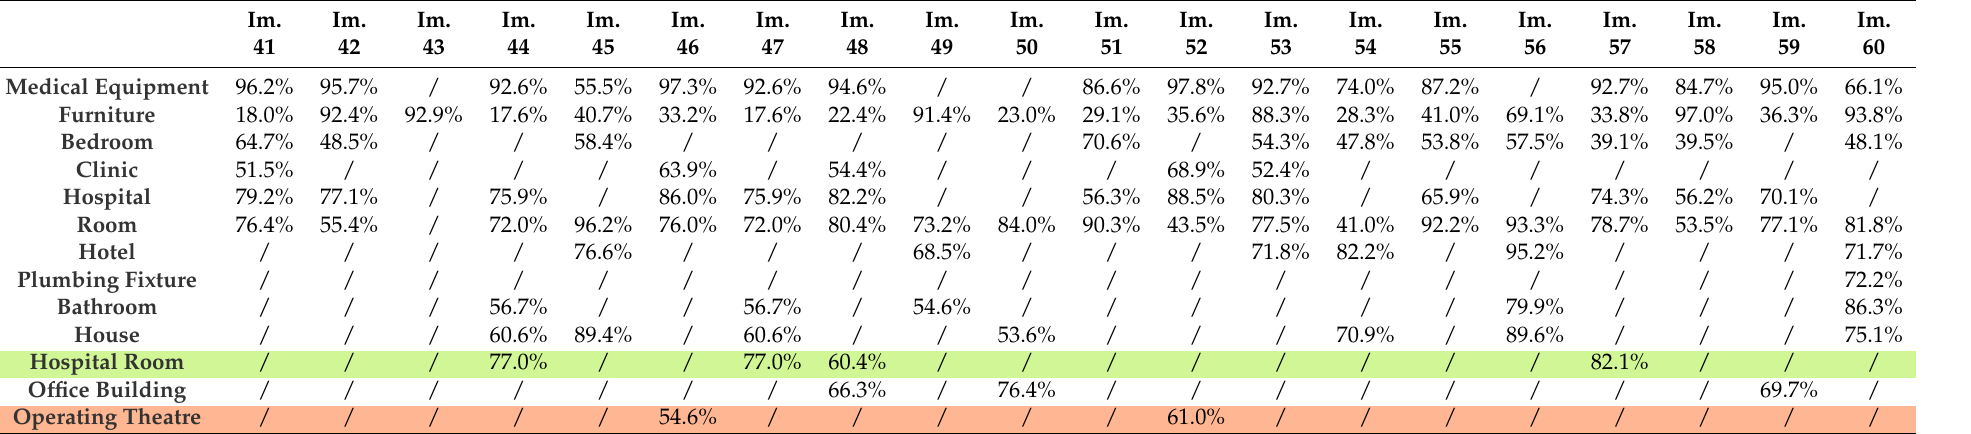
Table A3. Percentage of confidence obtained with Microsoft Azure Cognitive Services for the “hospitalisation” IU. Each column corresponds to Image 41 to 60 and each row is related to a different label that was returned by the model.